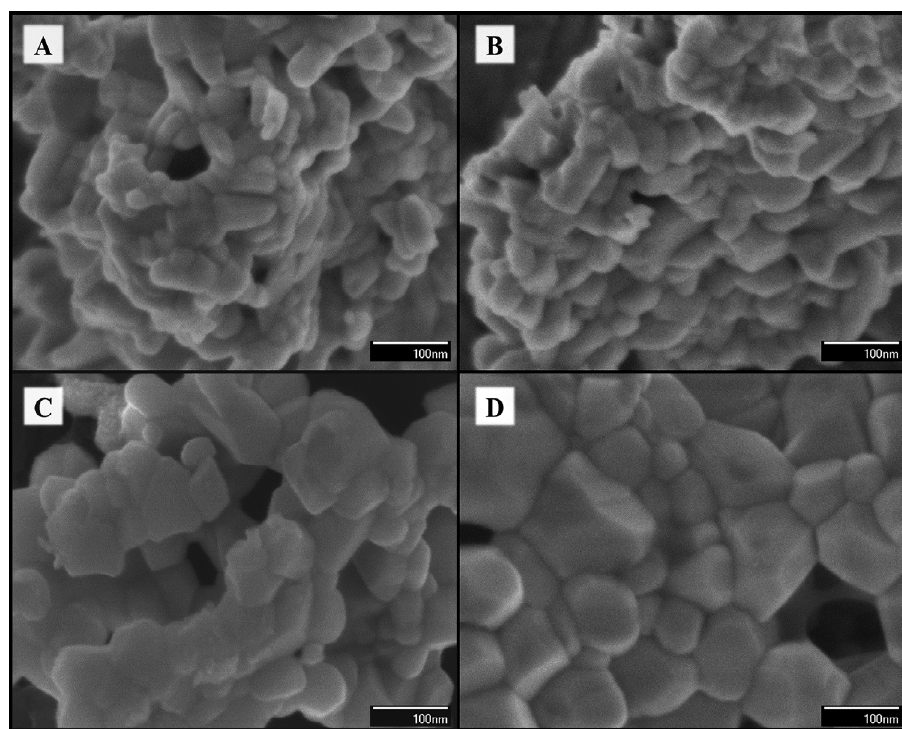
Ti O powders synthesized by combustion reaction and thermally treated at 4 3 12